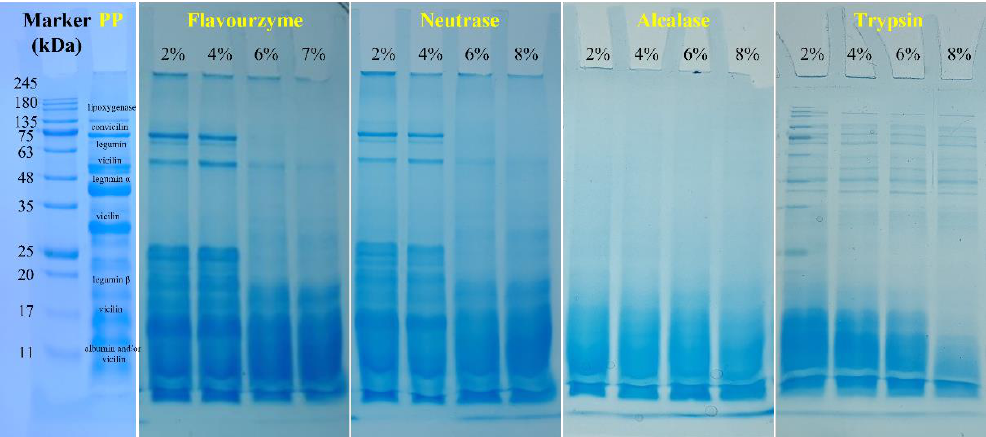
Figure 5. SDS-PAGE profiles of PP and PP with different DH samples under nonreducing condi- tions.